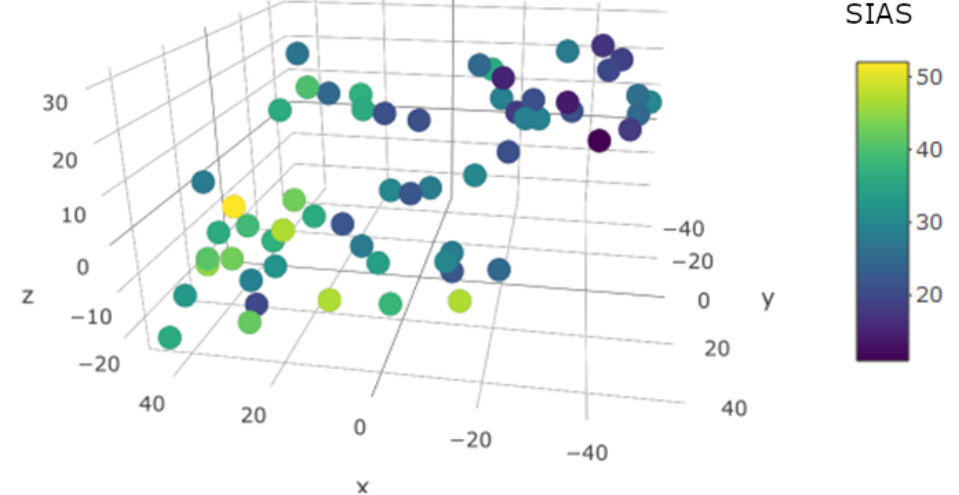
Figure 3. t-distributed stochastic neighbor embedding (t-SNE) plot depicting the ensembled model features (ie, the predictions extracted from the lower order ensembles) and the observed social anxiety symptoms. Note that closer points in the t-SNE are shown to be similar to one another, and dissimilar objects are shown to be farther away from one another. Note that the axes themselves are used to reduce the dimensionality of the machine learning features, so the Dimension 1, Dimension 2, and Dimension 3 labels are not of interest. This plot shows the ability to differentiate the level of social anxiety symptom severity based on the ensembled model features. As can be seen, the combination of the lower order ensembles was able to well differentiate SAD symptom severity. SAD: social anxiety disorder; SIAS: social interaction anxiety scale; t-SNE: t-distributed stochastic neighbor